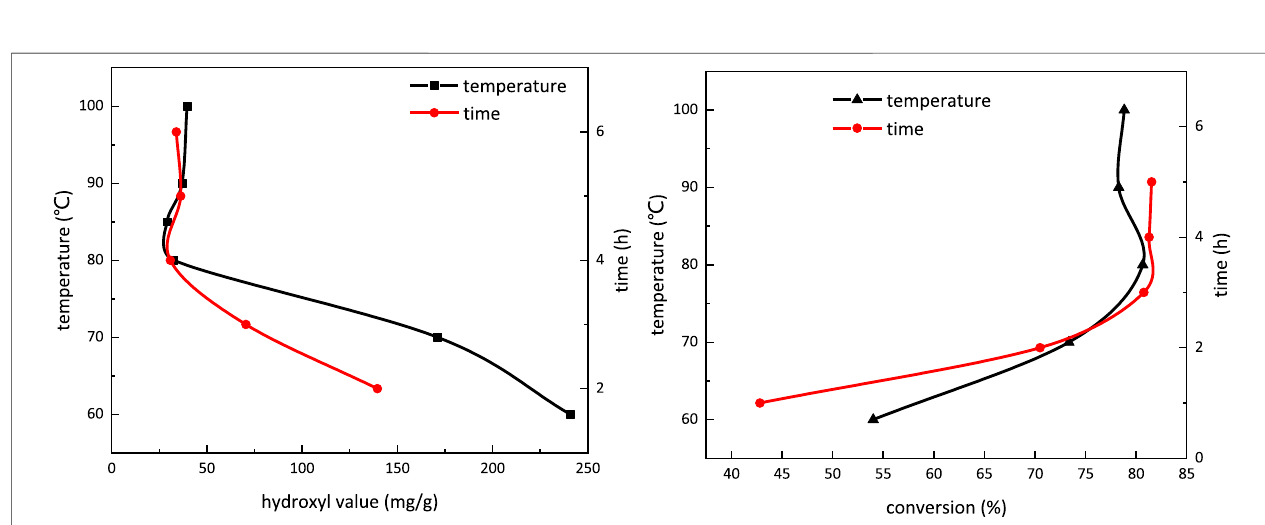
FIGURE 6 | In fl uence of temperature and reaction time on the hydroxyl value (A) and conversion (B) in the carboxymethylation reaction.